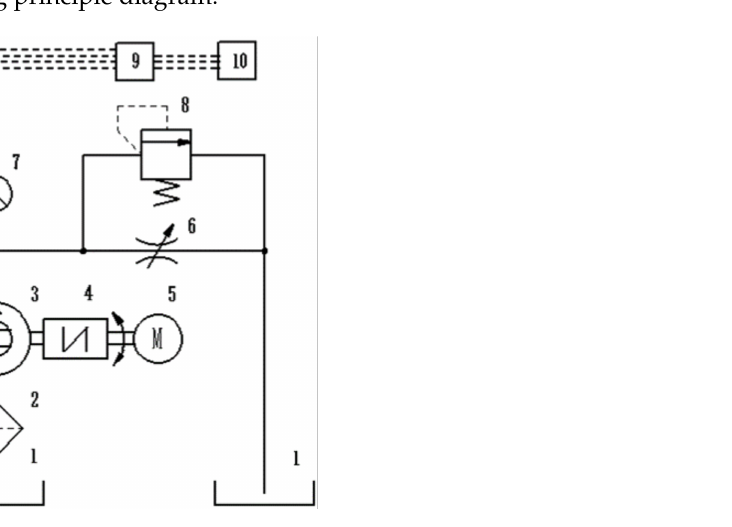
Figure 15. Schematic of the test system. 1-oil tank 2-filter 3-vane pump 4-coupling 5-motor 6-throttle valve 7-pressure gauge 8-overflow valve 9-digital temperature recorder